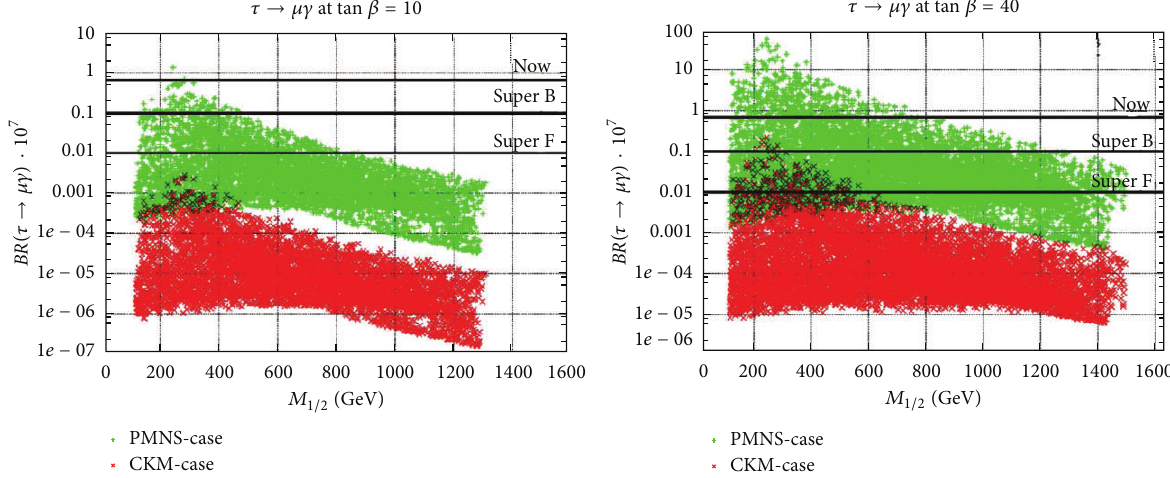
Figure 28: Predictions for 𝜏 → 𝜇𝛾 branching ratio obtained by scanning the LHC accessible SUSY-GUT (SO(10)) parameter space for two different values of tan 𝛽 as a function of 𝑀 1/2 [112]. Green (PMNS) and red (CKM) points indicate two different assumptions for the neutrino Yukawa coupling ( 𝑌 ] ). The experimental bound set by B factory experiments is reported, together with the expected sensitivities of Super B and SuperBelle (indicated with Super F)